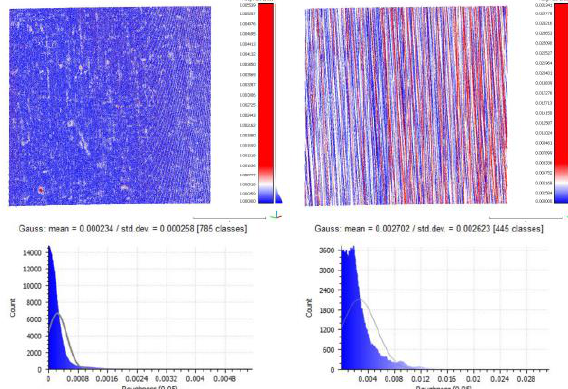
Figure 11. Analysis of a wall planar surface: roughness index comparison between TLS (left) and MMS (right). The analysis has been performed using CC (di/V sphere r = 0.05 m).